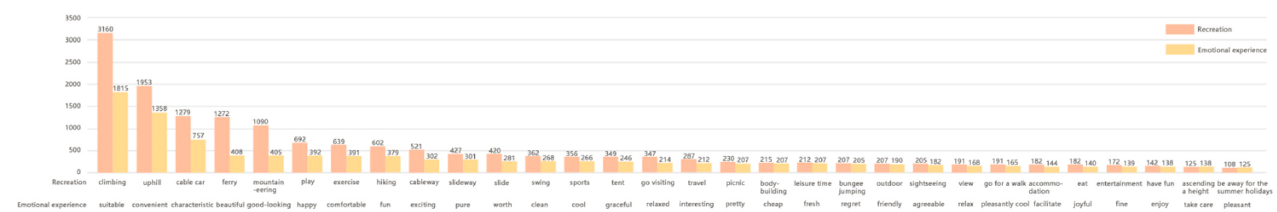
Figure 8. Frequency of the top 30 words related to recreation and emotional experience.